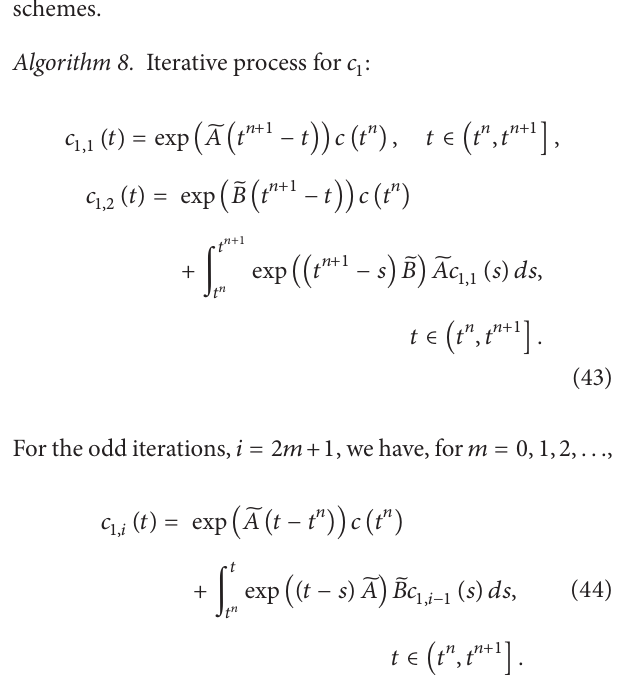
Algorithm 8. Iterative process for 𝑐 1